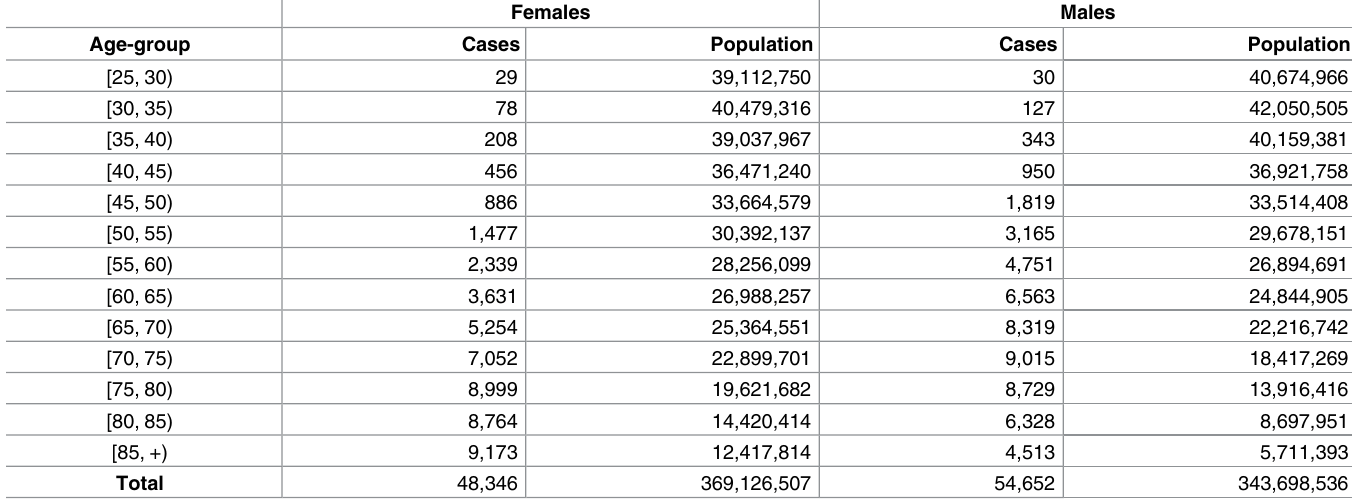
Table 1. Age-specific pancreatic cancer deaths and the corresponding aggregated population by gender in the period (1990–2013) in Spain.